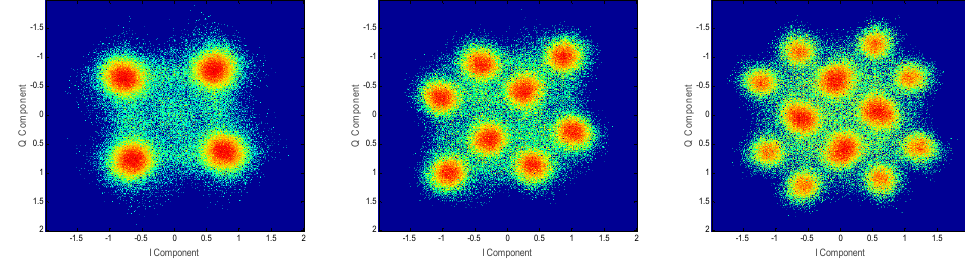
Figure 9. QZSS satellite L6 frequency constellations.